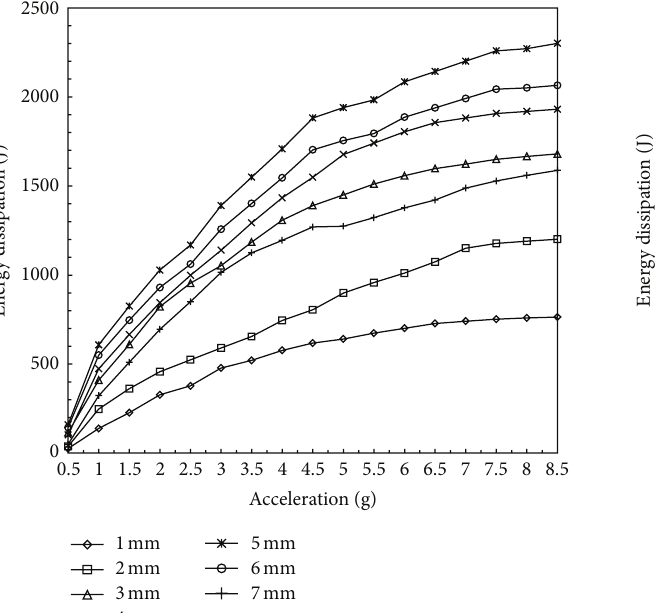
Figure 13: The experimental results for the different particle filling